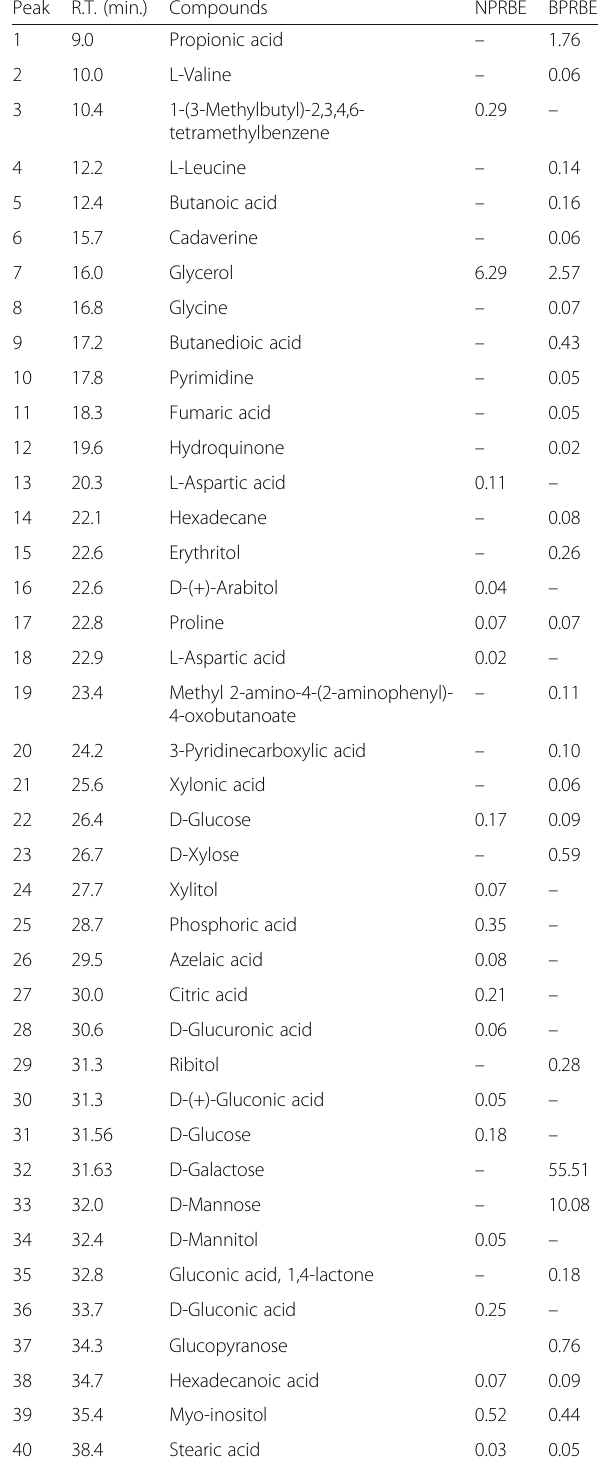
Table 1 Compounds identified by GC/MS analysis of NPRBE and BPRBE Peak R.T. (min.) Compounds